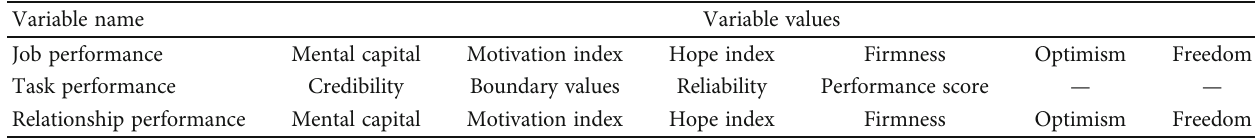
Table 3: Descriptive statistical analysis of job performance and its